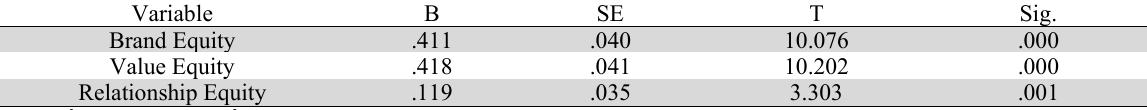
The results of regression analysis (Dependent variable: Attitudinal Customer